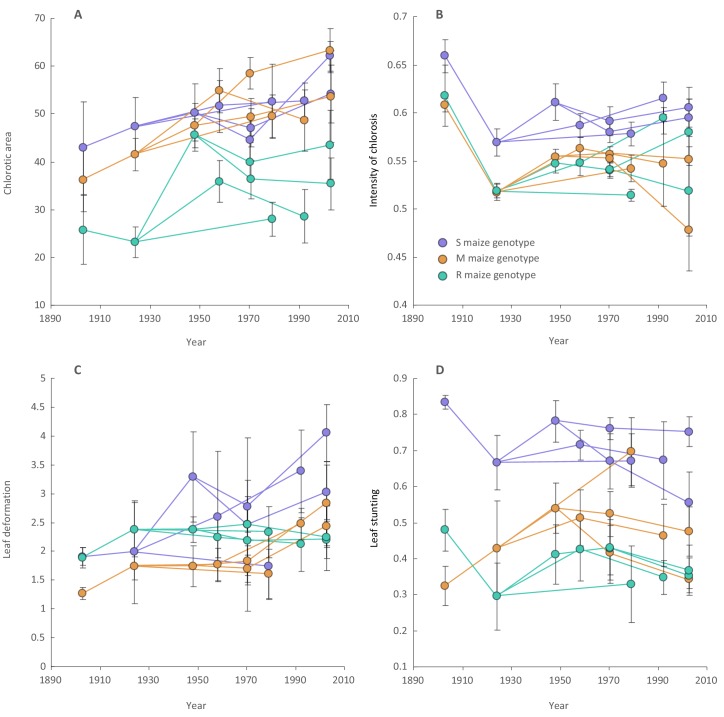
Changes in MSV-A symptom intensities over time across viral lineages descending from the most recent common ancestor of all known MSV-A isolates.Included here are mean symptom measurements for individual synthesised approximations of ancestral MSV-A isolates (all of which existed prior to 1975) and means of symptom measurements of different viruses descending from these ancestral sequences (all of which were sampled between 1979 and 2007). Symptom measurements were made in sensitive (S; in purple), moderately resistant (M; in orange) and resistant (R; in green) maize genotypes. Lines link ancestral sequences (on the left) with direct descendants (on the right). Error bars on each point falling before 1980 are the 95% confidence intervals of the mean of repeated symptom measurements made for an individual ancestral virus in a single maize genotype. Error bars on each point falling after 1980 are the 95% confidence intervals of the mean of averaged symptom measurements in a single maize genotype made for multiple sampled viruses that all descended from a single ancestral virus.